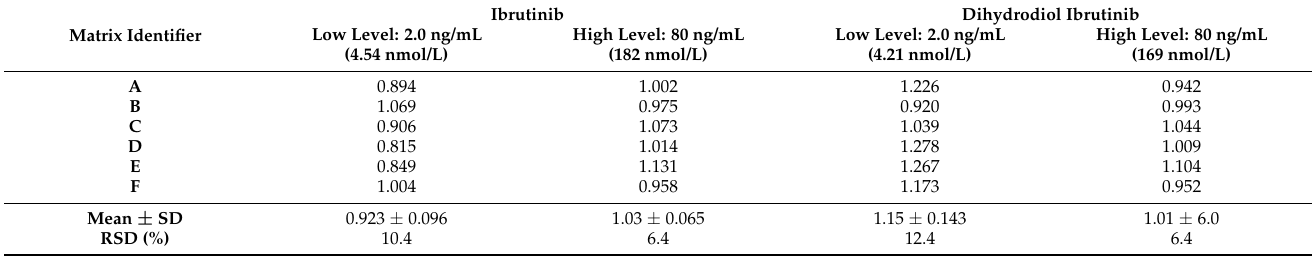
Internal standard-corrected matrix factors of ibrutinib and dihydrodiol ibrutinib. Six independent human serum matrices (A-F) and two spiking levels were used. SD, standard deviation. RSD, relative standard